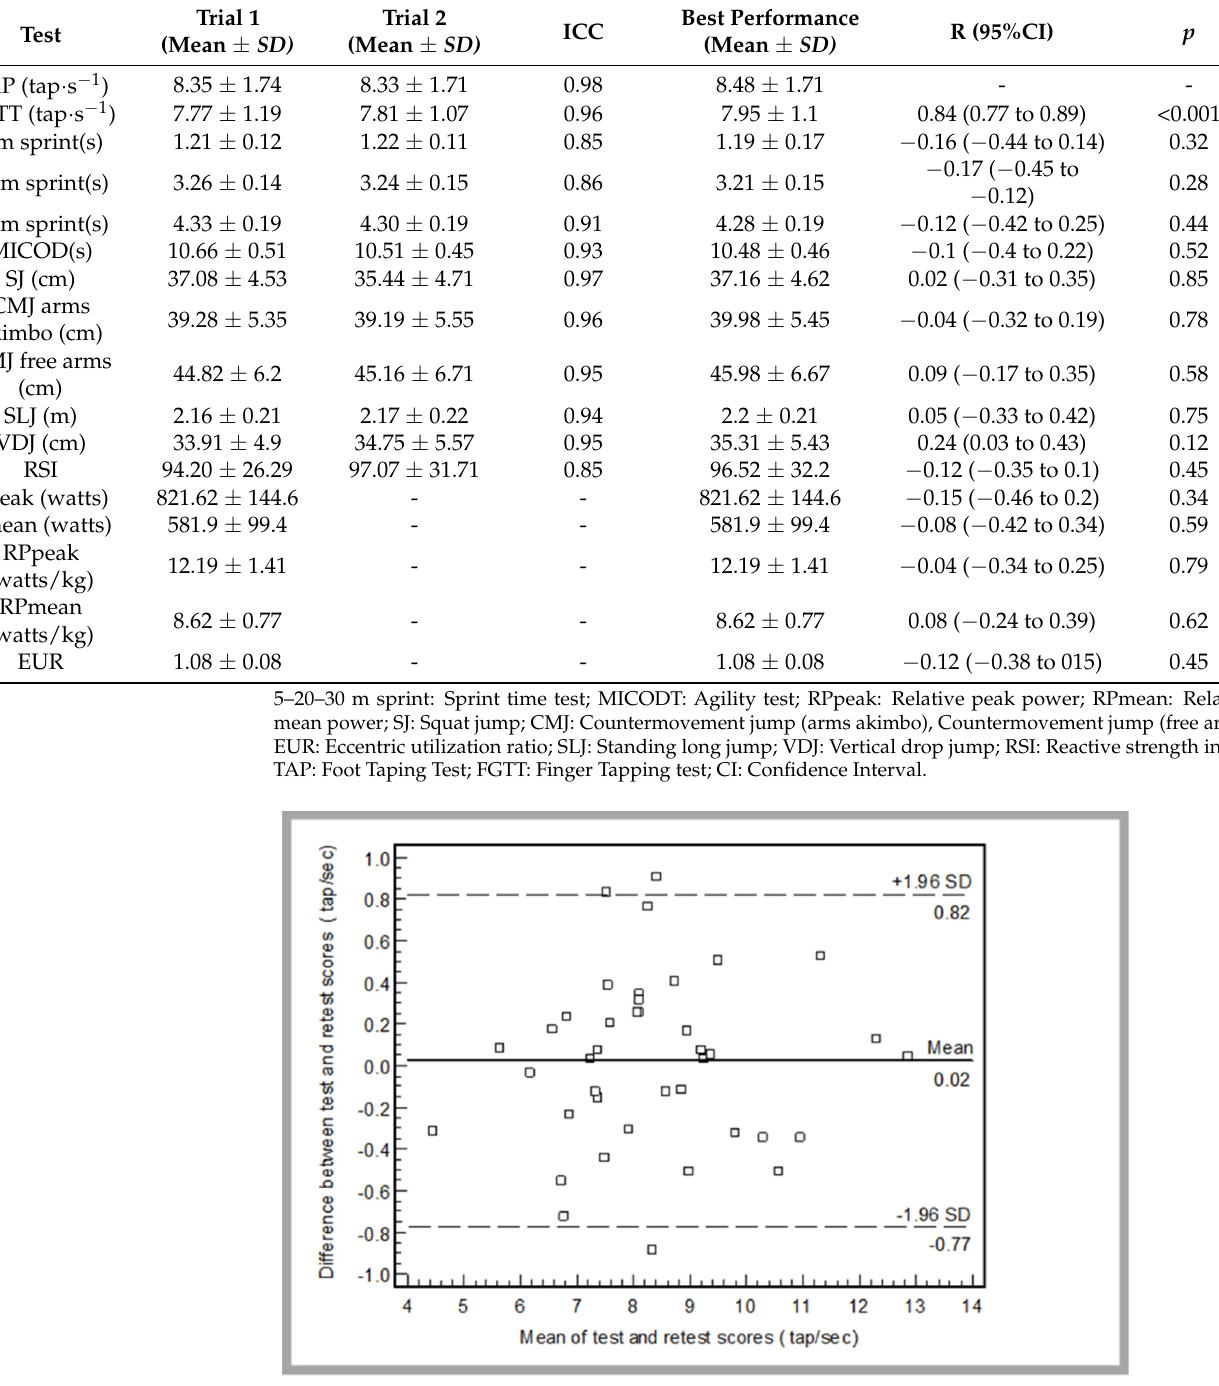
Table 3. Mean ± SD of players performances, Intraclass Correlation between trials 1 and 2 (ICC), correlation coefficient (r) between TAP test and other physical qualities and associated probability values ( p ). Test